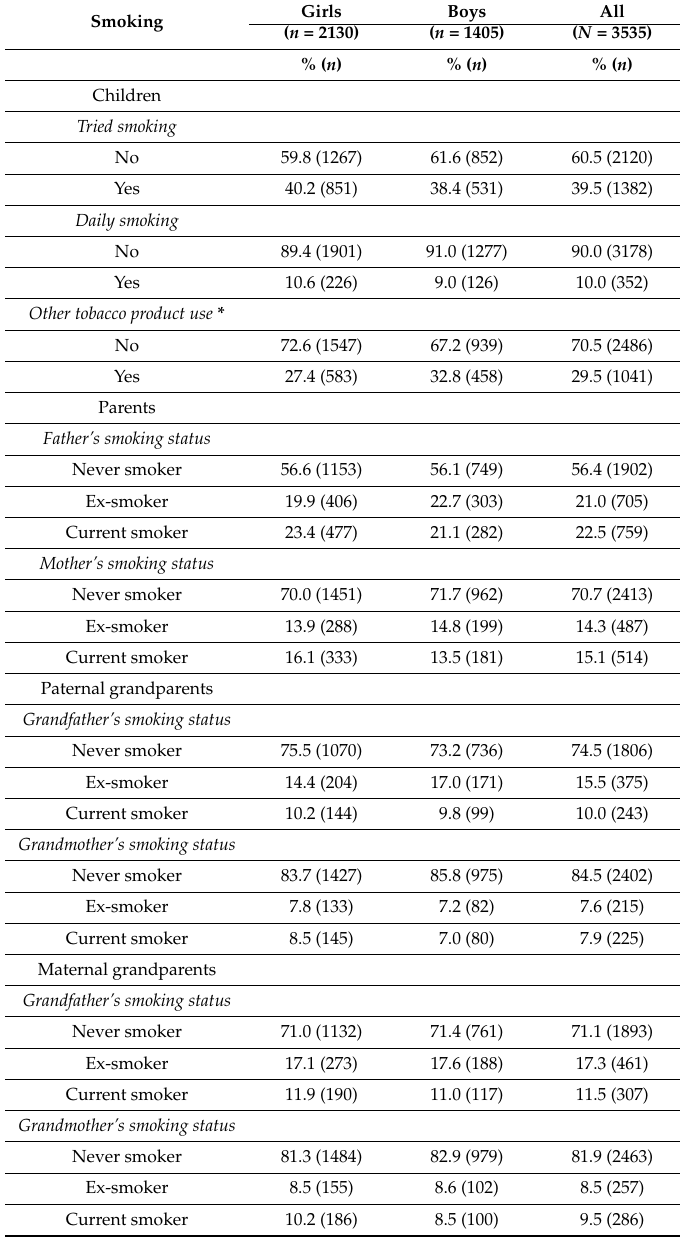
Table 1. Distribution of children’s smoking experimentation, daily smoking and other tobacco product use * and parents’ and grandparents’ smoking by